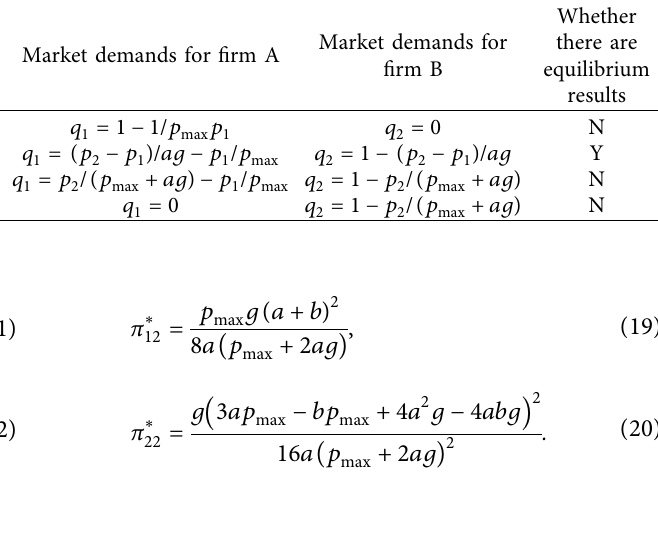
Table 2: Analytical results for demand functions under several different